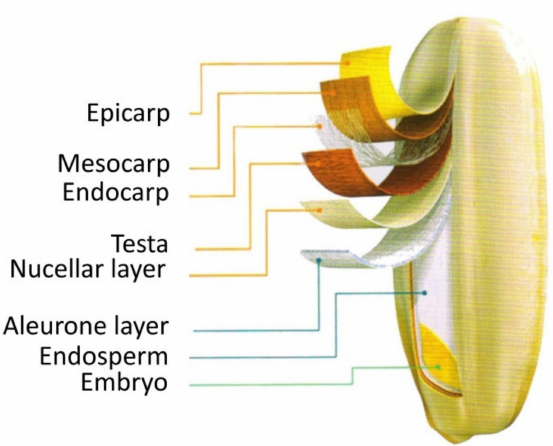
Figure 1. Morphology of a ripe rice grain (caryopsis). The figure is made according to